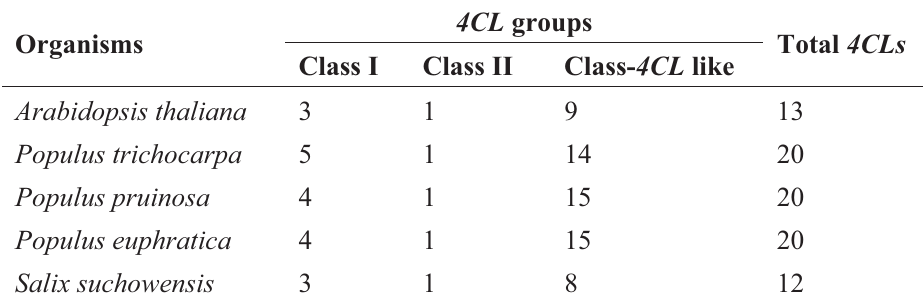
Table 1. Comparison of 4CL gene family sizes in the five considered